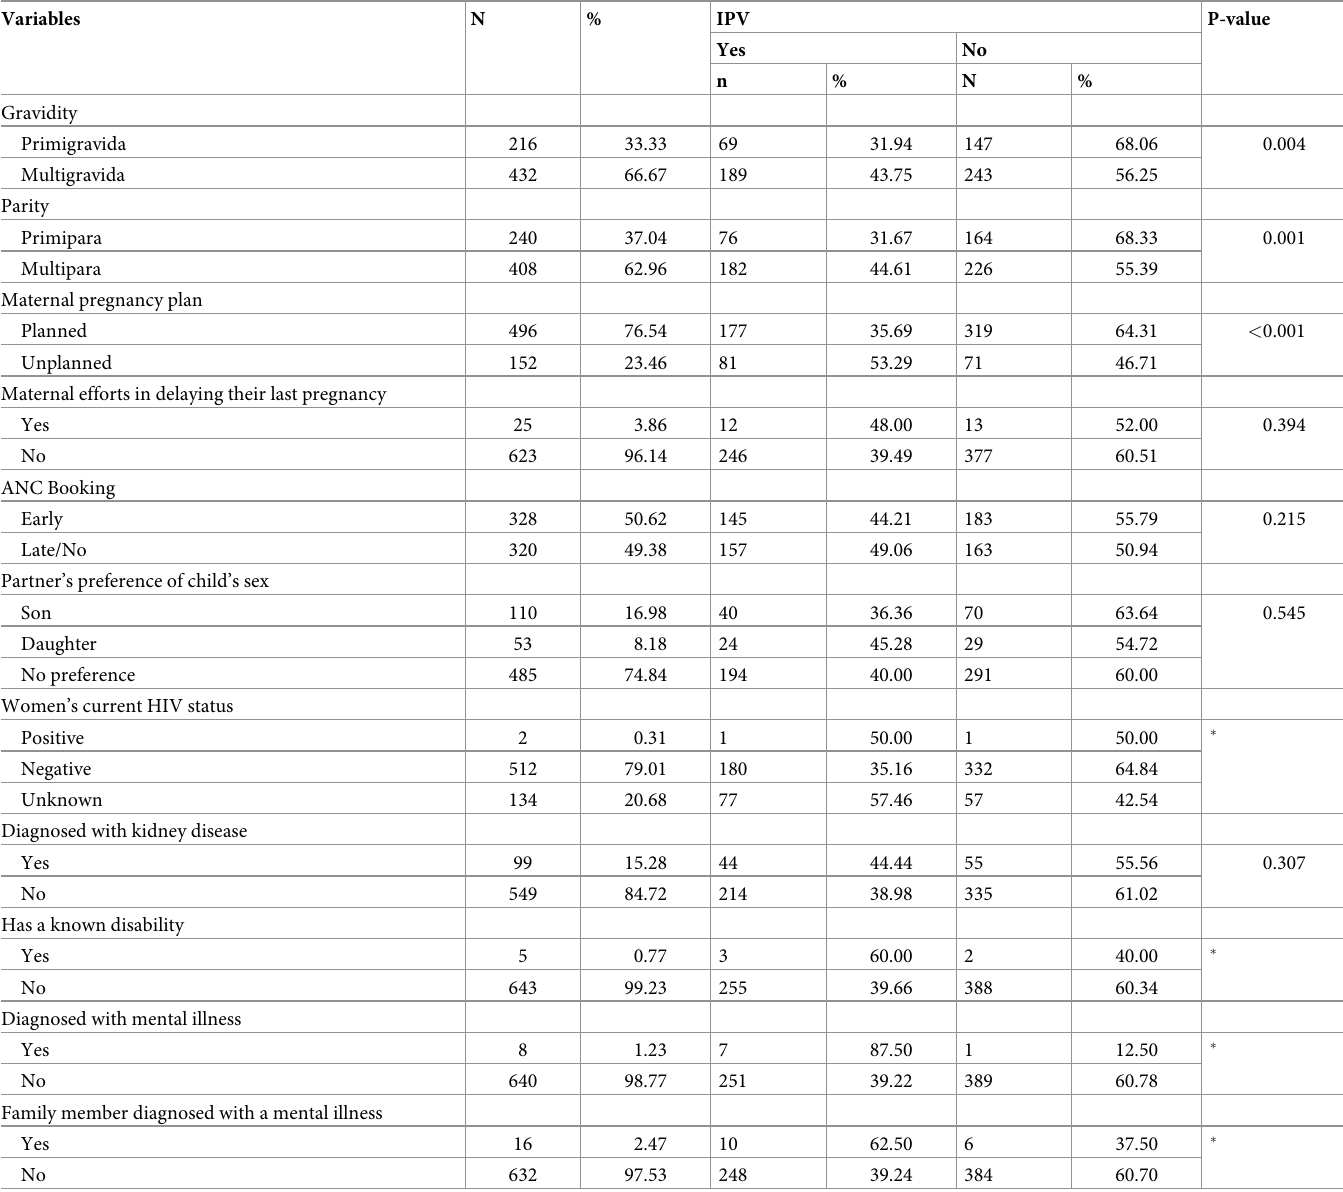
Table 4. Reproductive and physical health-related factors of women who gave birth in public hospitals in Harari regional state, East Ethiopia, 2018–2019. Variables